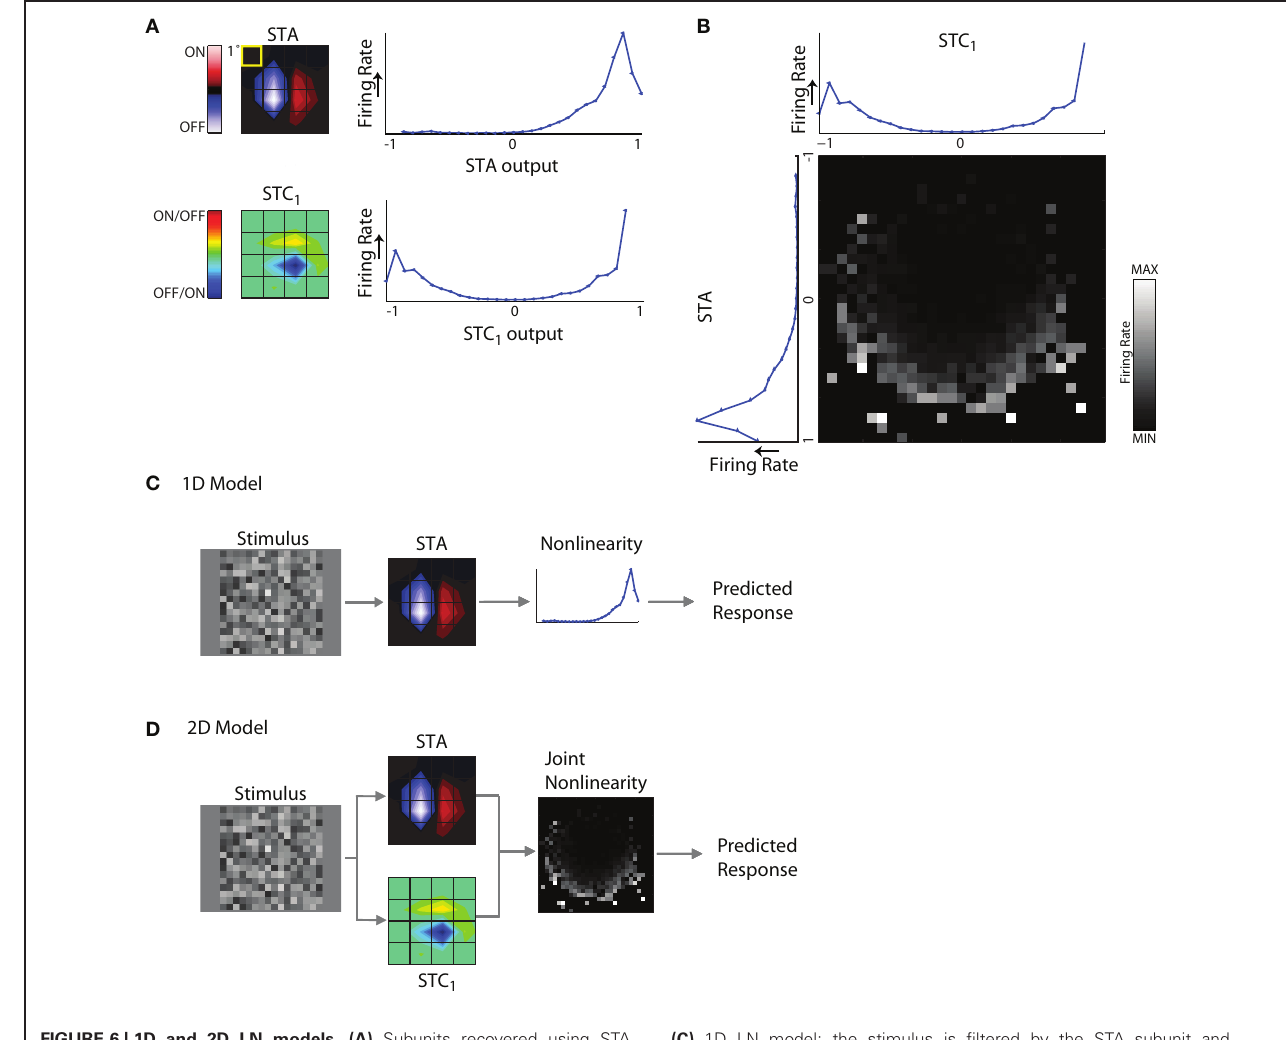
FIGURE 6 | 1D and 2D LN models. (A) Subunits recovered using STA and STC analysis with the corresponding response non-linearities for an example cell. (B) Joint response non-linearity, displayed as grayscale map, with the corresponding 1D non-linearities shown at the left and top ; the brighter entries in the map indicate stronger neural